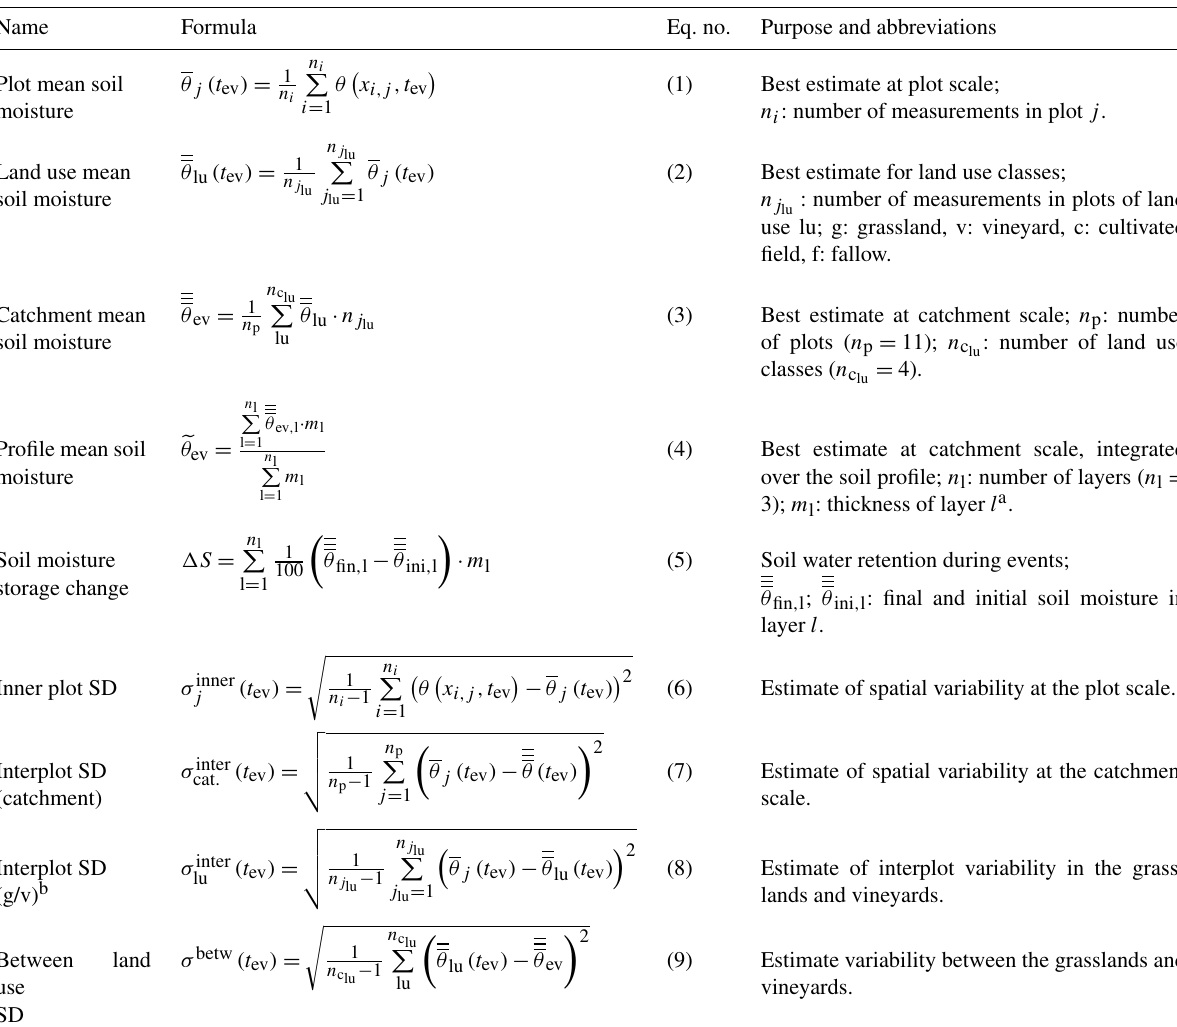
Table 1. Calculated measures of averaged soil moisture and its variability at different scales.